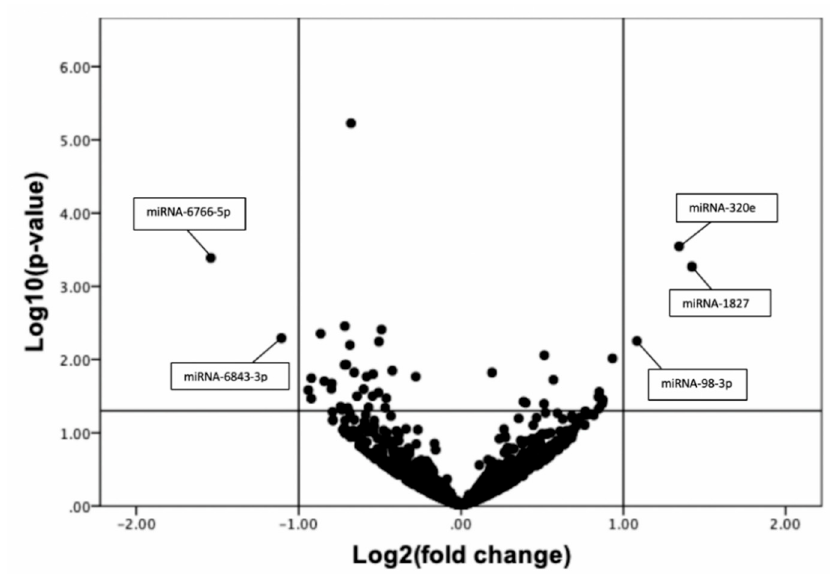
Figure 1. Volcano plot representing the fold change and p -values for all miRNA identified via Next Generation Sequencing in CLTI patients ( n = 13) relative to non-PAD controls ( n = 10). All miRNA with at least 2-fold increase and p -value p < 0.05 are shown in the top left box (down regulated) and top right box (up regulated).